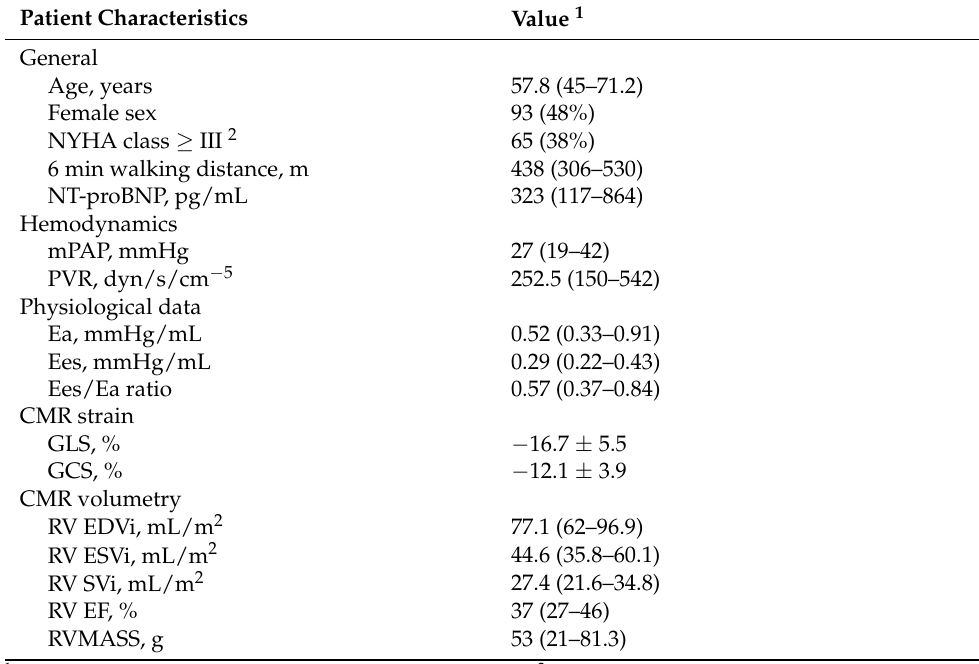
Table 1. Patient